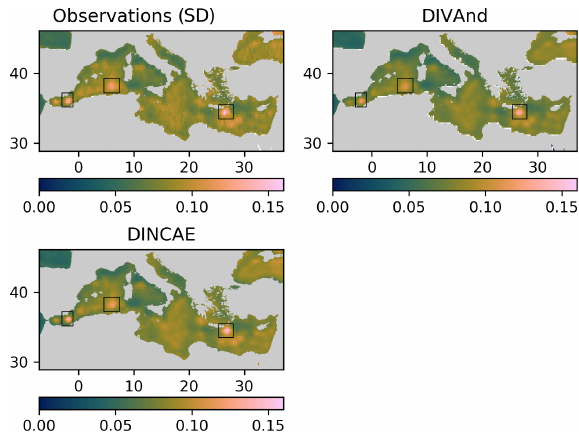
Figure 11. Standard deviation of the sea-level anomaly for the DI- VAnd method and DINCAE (including SST as auxiliary